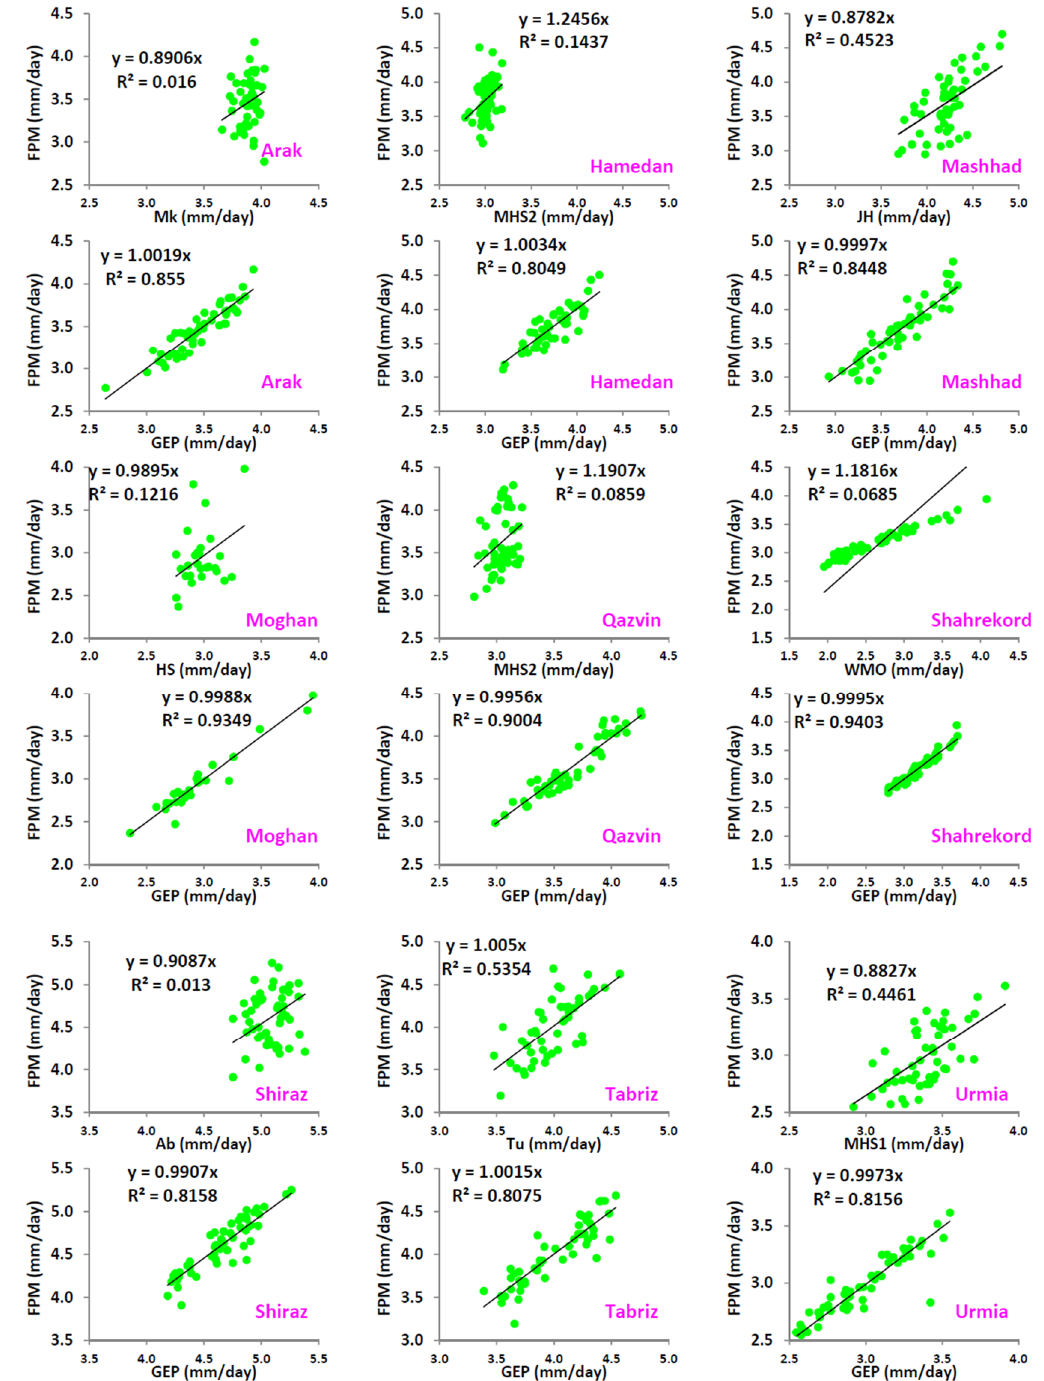
Figure 3. Accuracy of empirical models (annual mean ETo) against gene expression programming (GEP) in semiarid climates.